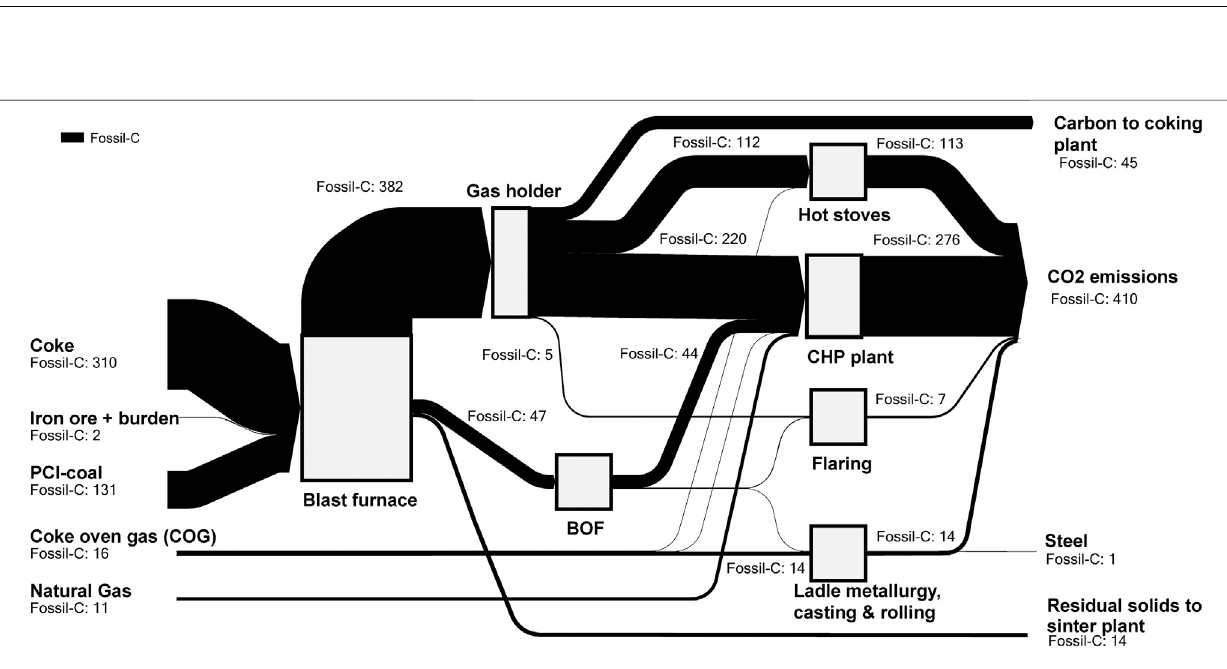
FIGURE 2 | Carbon balance of the reference integrated steel mill excluding units upstream of the blast furnace (coke ovens, lime kiln, sinter plant) according to the bluesystemboundaryin Figure1 .Themassbalancesarederivedfrompreviouspaper(IEAGHG, 2013).Thevaluesshownarepresentedinkilogramsofcarbonperton of hot-rolled coil